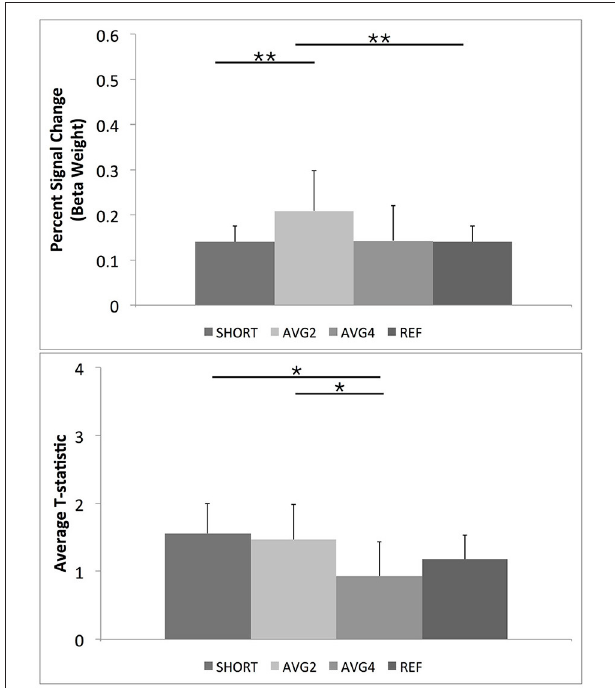
FIGURE 7 | Post-hoc results for repeated measures ANOVAs for BOLD percent signal change and GLM-calculated T -statistics for the full FSL Harvard-Oxford brain atlas. As described in the text, SHORT, TR = 700 ms; AVG2, TR effective = 1440 ms; AVG4, TR effective = 2800 ms; REF, TR = 1400 ms. Percent signal change values were calculated from the beta weights estimated during the GLM. **Indicates a post-hoc difference at p < 0.05, Bonferroni corrected for comparing across the four different EPI sequences. *Indicates a post-hoc difference at p < 0.05,